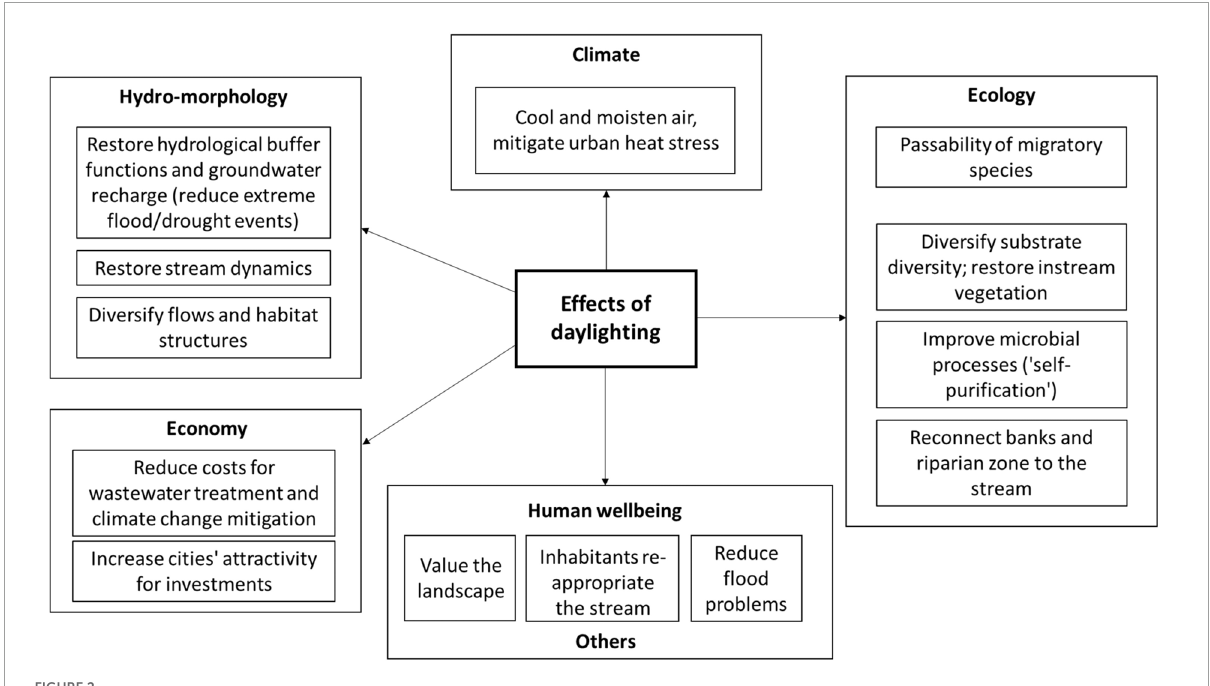
FIGURE2 Benefits of stream daylighting. See text for